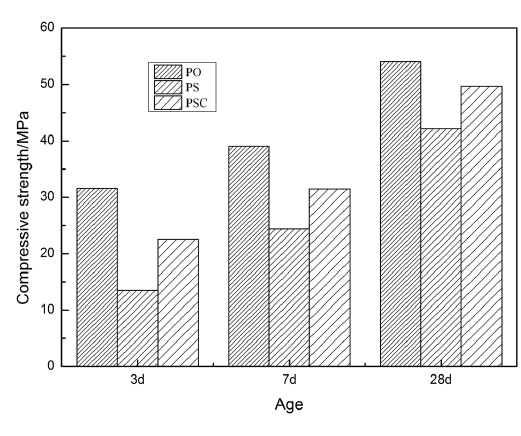
Fig. 4. The compressive strength of three gelling materials at different hydration